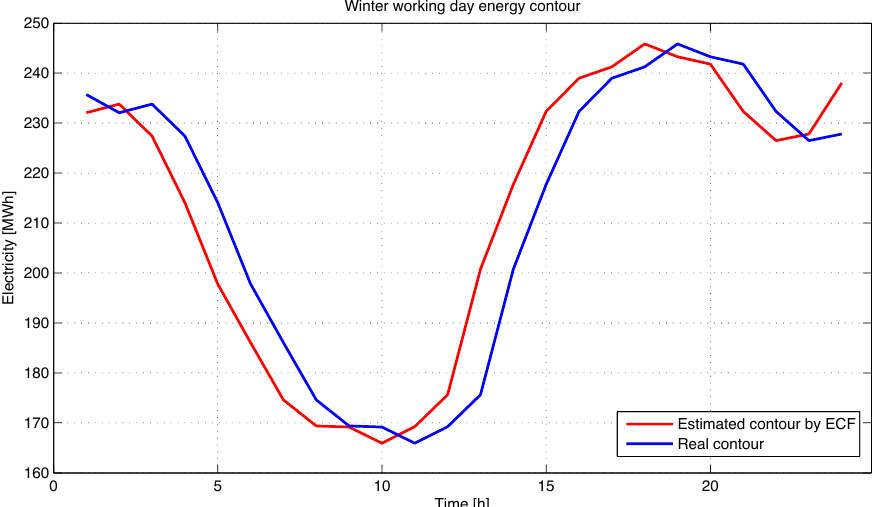
Figure 6. Estimation of energy contour by Frequency Feature Based Method (ECF) for a winter working day.